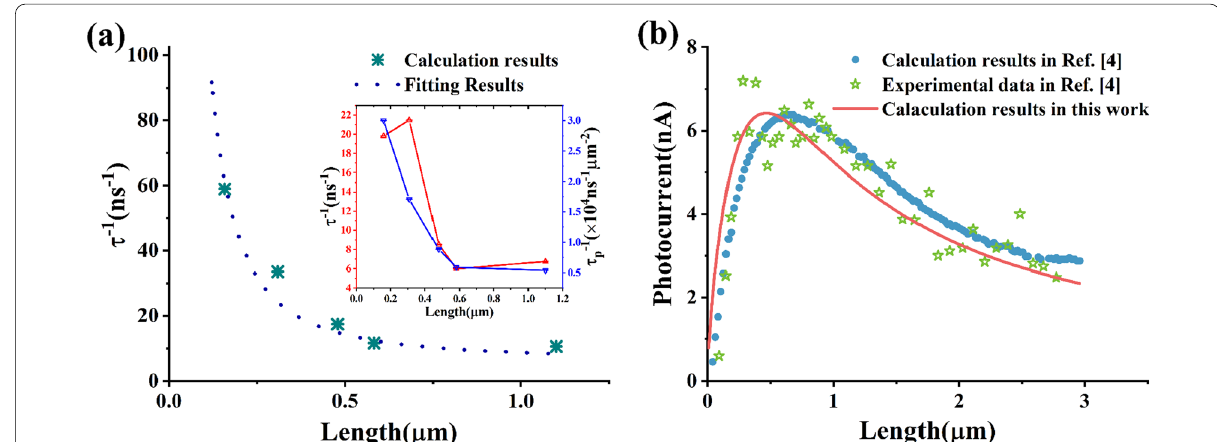
Fig. 3 a The length-dependent recombination rate of ZnO NWs with a diameter of 50 nm we obtain from the model. Inset: the recombination rate τ − 1 and the recombination rate per unit area τ − 1 p are calculated from the experimental data in Ref. [32]. b Comparison of the results calculated in this work with the experimental and calculation ones in Ref. [4]. Under a voltage of 10 V, the photocurrent as the function of the height of ZnO NWs with a diameter of 50